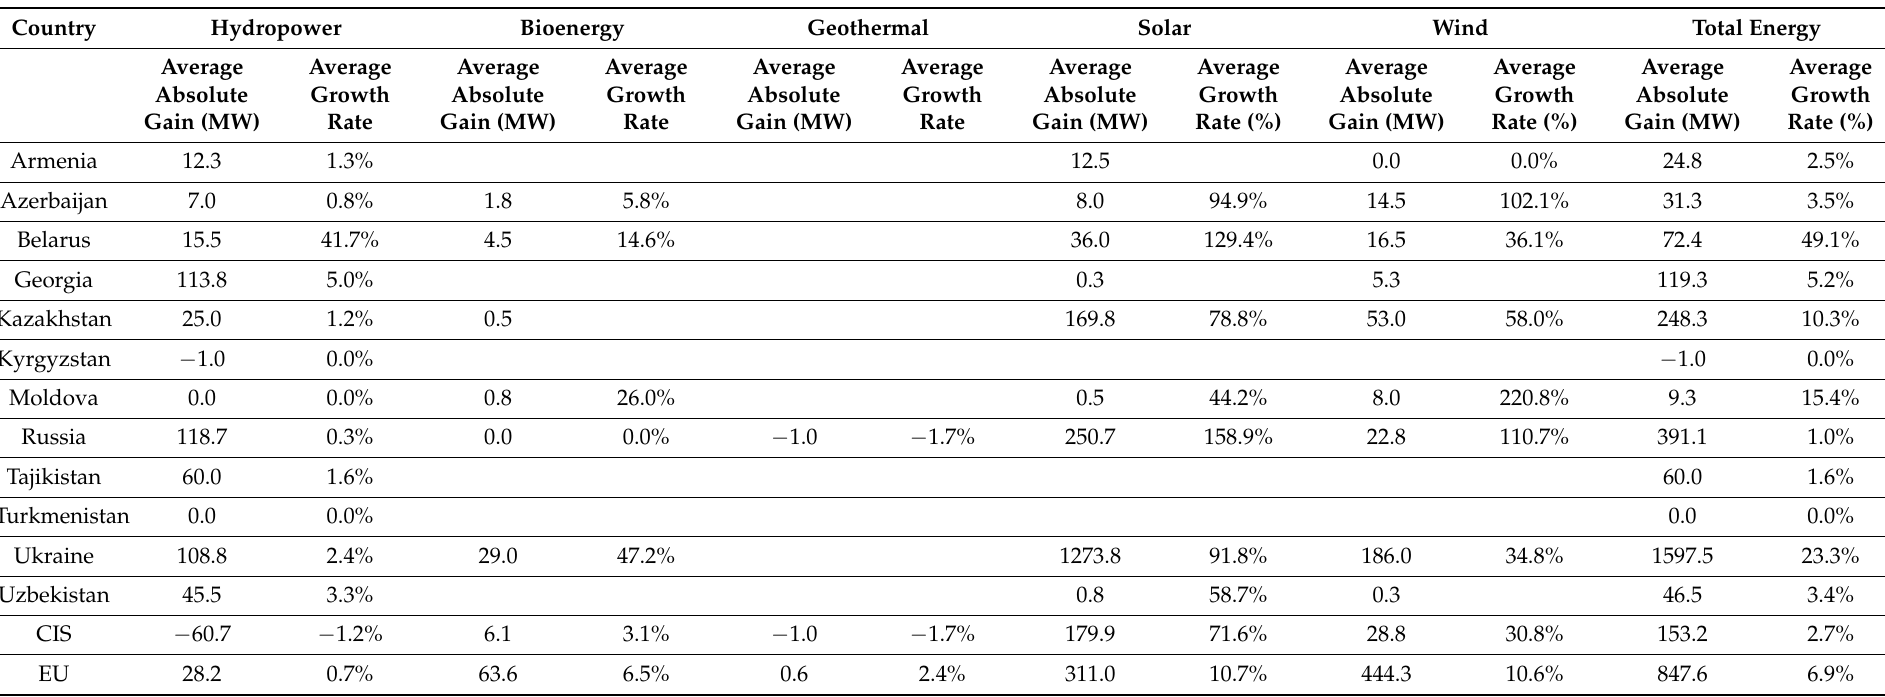
Table 2. Dynamics of changes in the energy potential of the CIS countries and the average potential for EU countries in